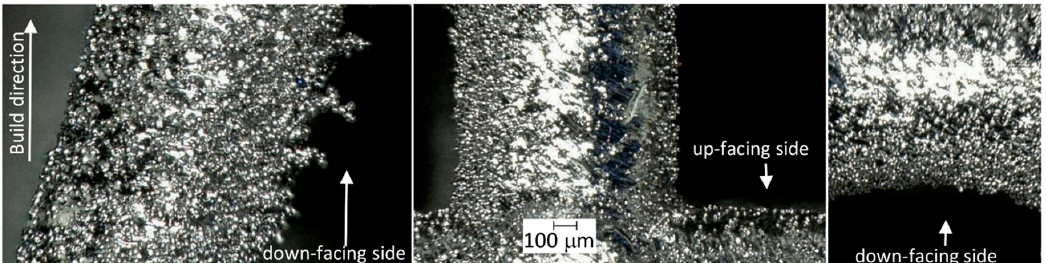
Figure 4. Representation of the roughness of struts as a result of their individual orientations; ( Left) —slanted struts show at the bottom (the powder bed side) a build-up of molten powder particles; ( Centre) —image vertical struts, as well as the top of horizontal struts (the powder bed opposite) show no build-up of powder particles; ( Right) —horizontal struts show at the bottom (of the powder bed facing side) a build-up of melted powder particles.